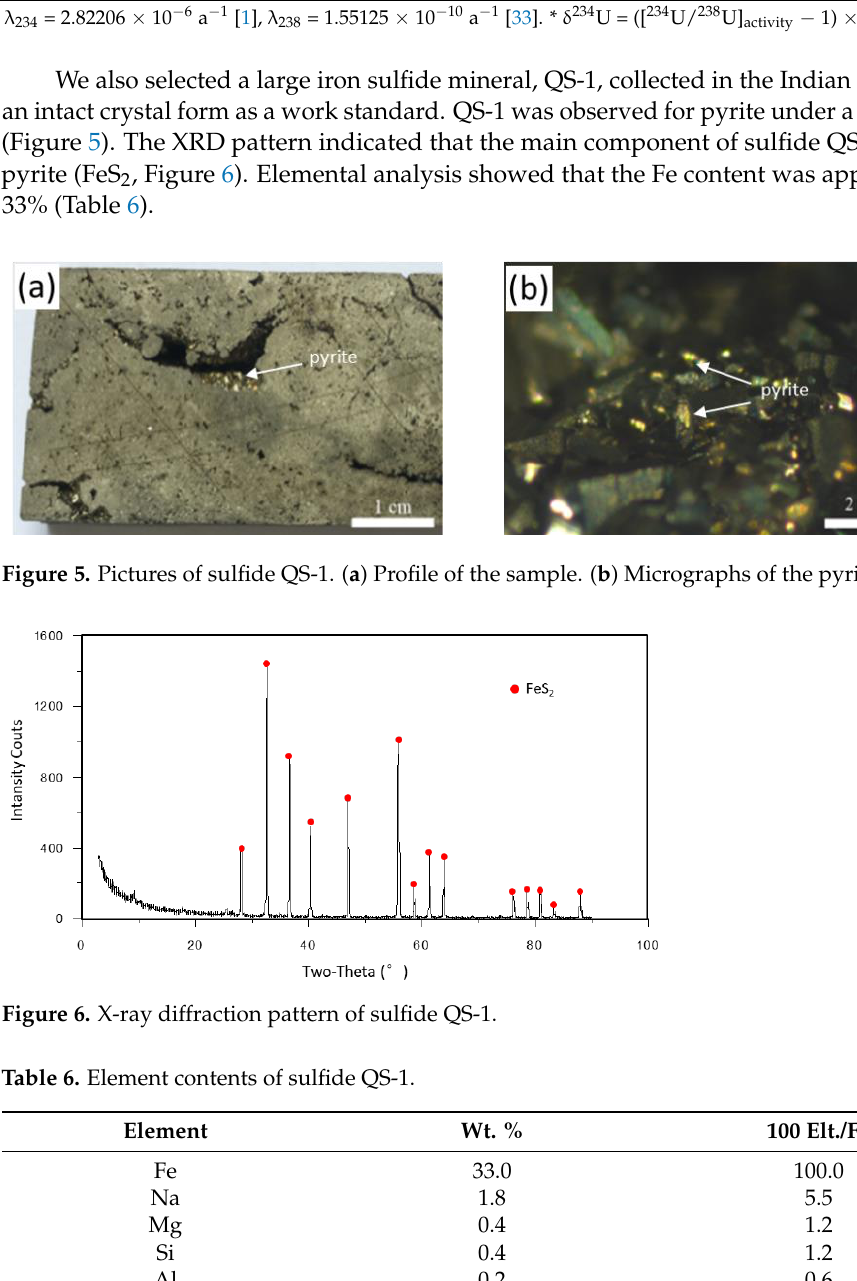
Table 7. U-Th contents and isotopic ratios for sulfide QS-1 (± 2σ, absolute value) .